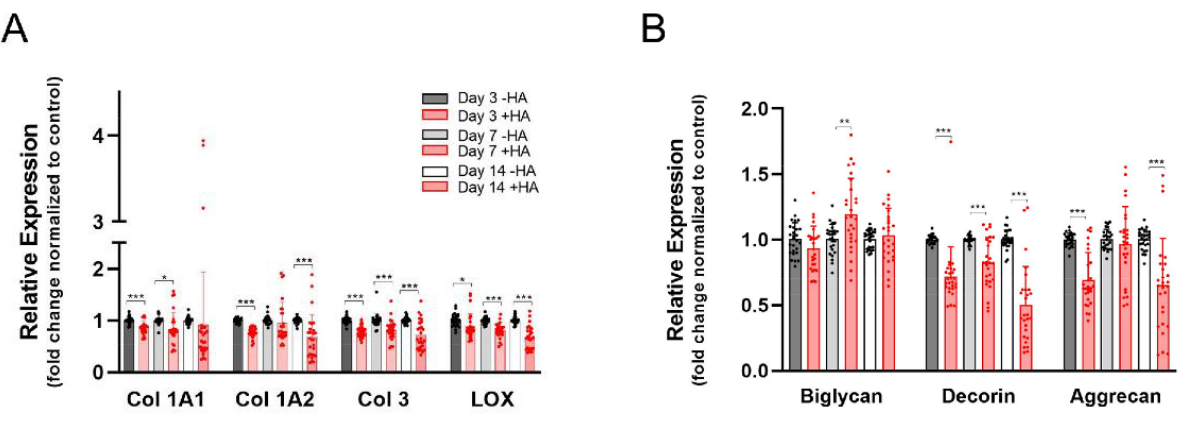
Figure 2. Extracellular matrix components collagen IA1 (Col IA1) , collagen IA2 (Col 1A2) and collagen 3 (Col 3) as well as lysyl oxidase (LOX) responsible for crosslinking collagen fibers ( A ). Proteoglycans occurring in tendon tissue; biglycan , decorin and aggrecan ( B ). Stars indicate pairwise comparison probability in Student’s t test, where HA was compared to the control: p < 0.05 (*), p < 0.01 (**) and p < 0.001